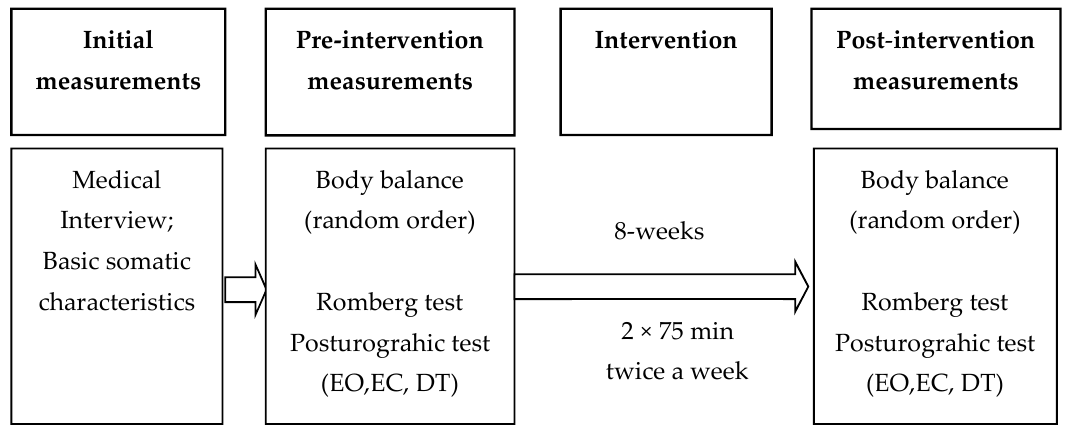
Figure 1. General overview of the experiment. Note: EO—Eyes Open, EC—Eyes Open, DT –Dual Task.